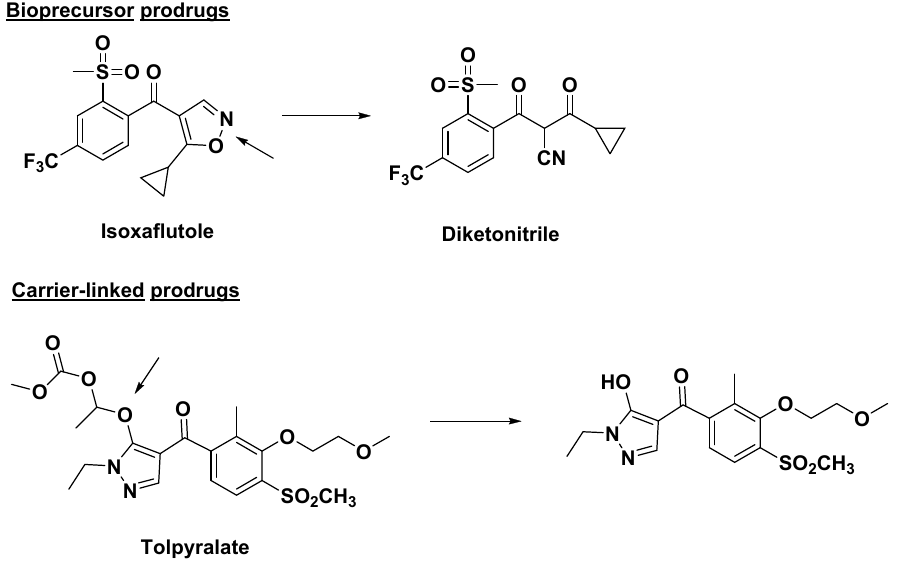
Figure 7. Some bioprecursor pro-herbicides and carrier-linked pro-herbicides. Arrows indicate reaction sites for biological and chemical transformation.